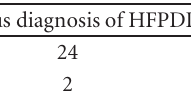
Table 1: The concordance of clinical diagnosis and ADI-R scores above